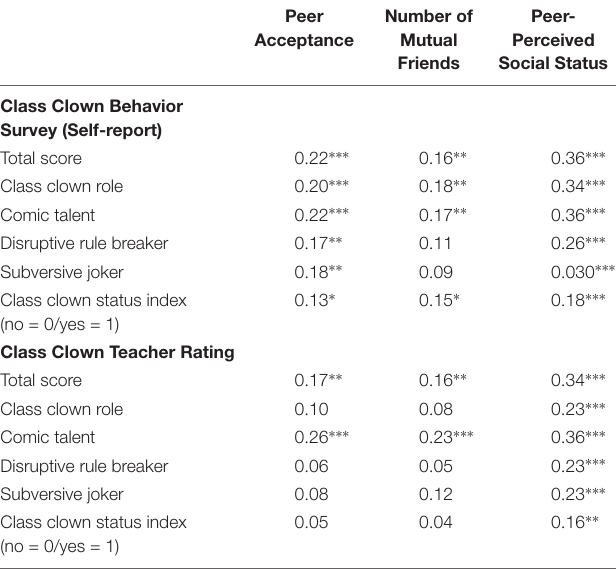
TABLE 2 | Results of multilevel models predicting peer acceptance, number of mutual friends, and peer-perceived social status (controlled for age and sex): Standardized coefficients for the fixed effects of the predictors (Class Clown Behavior Survey and Class Clown Teacher Rating) of the respective random-intercept models for each predictor entered separately. TABLE 3 | Results of multilevel models predicting peer acceptance, number of